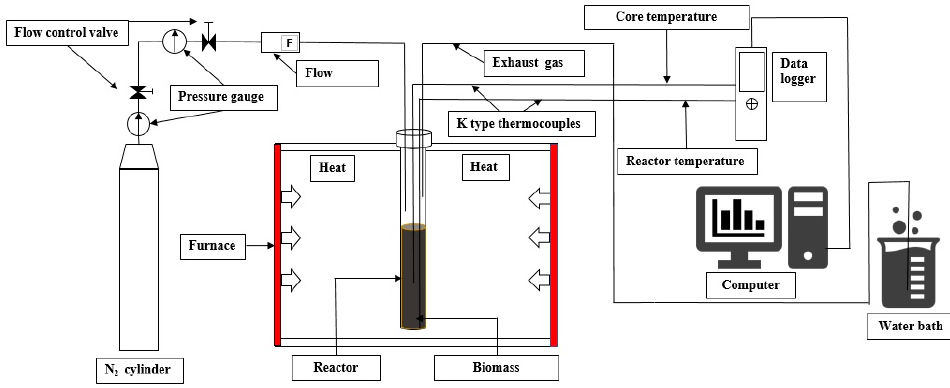
Figure 2. Schematics of the lab-scale experimental set up of the slow pyrolysis